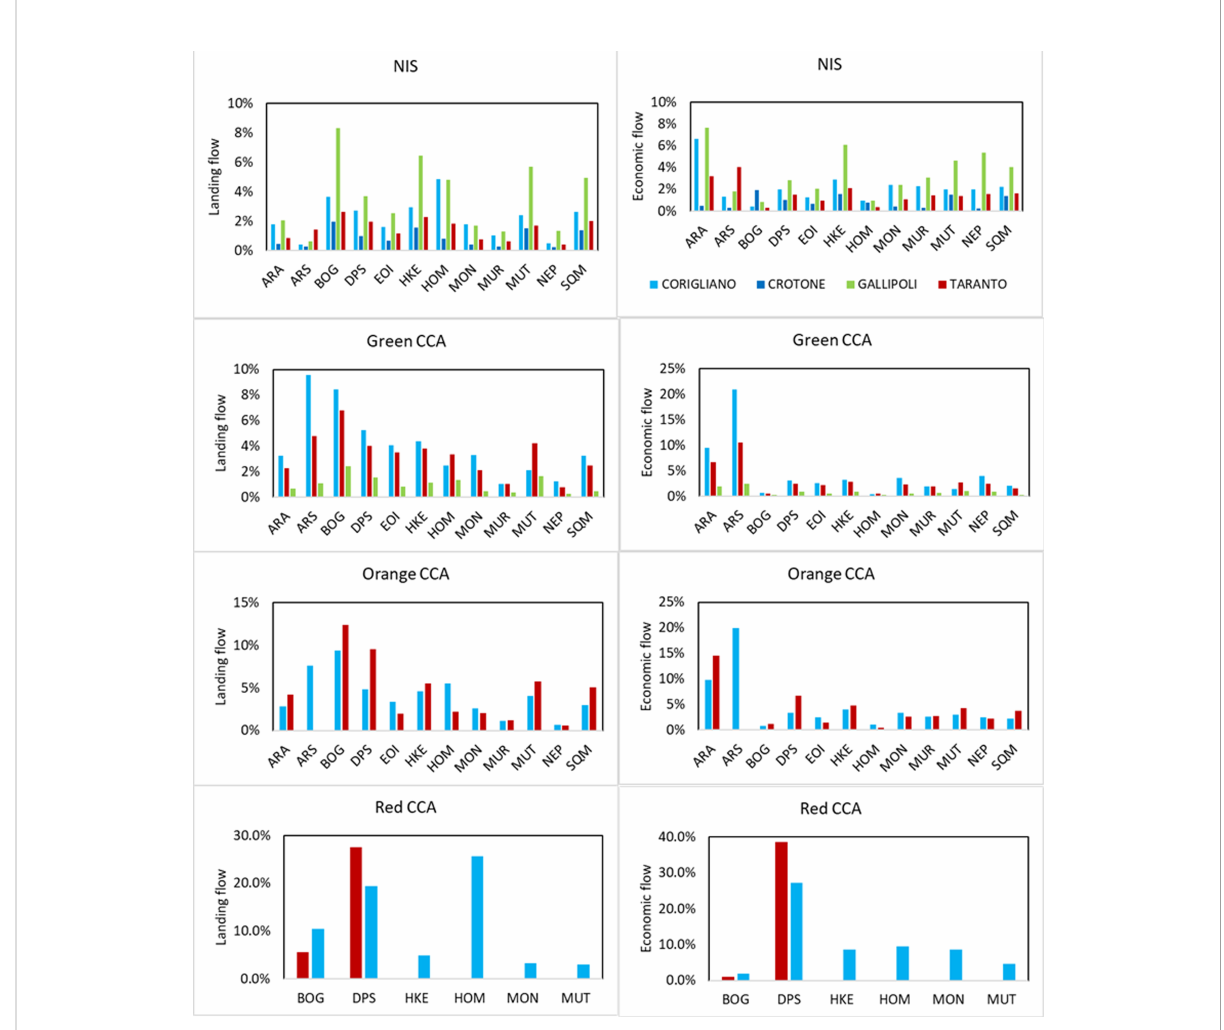
FIGURE 8 Landing fl ows by species (expressed in %) from the CCAs and NIS towards the main fi shing harbours. Species codes are reported in Table